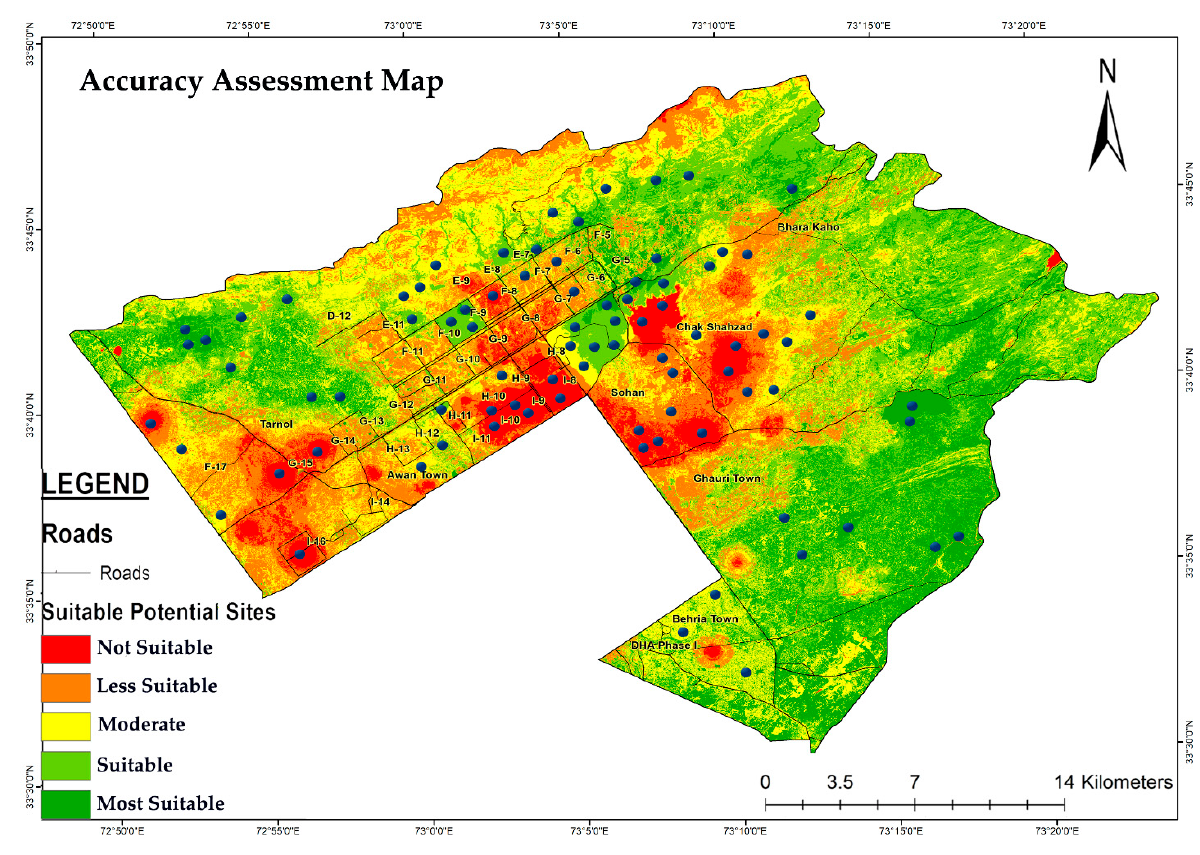
Figure 10. Accuracy assessment Map. Table 10. Accuracy Assessment Calculation.